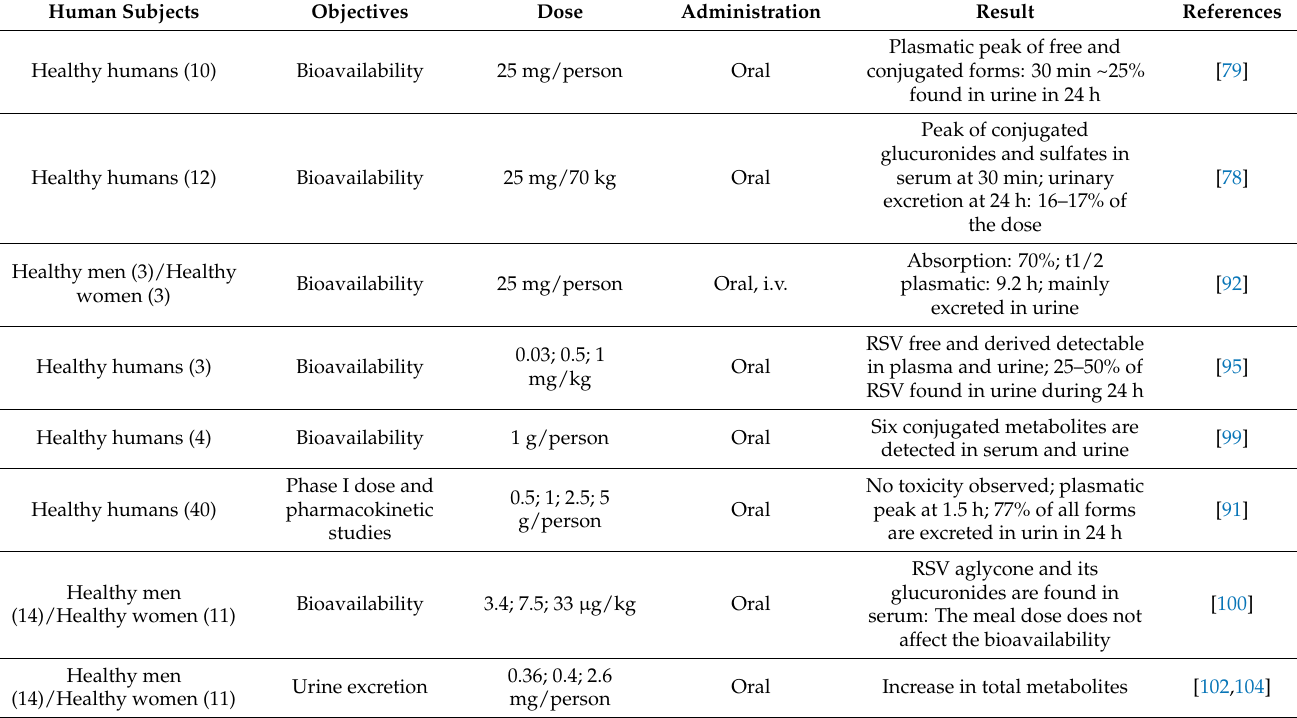
Table 2. Clinical studies of RSV